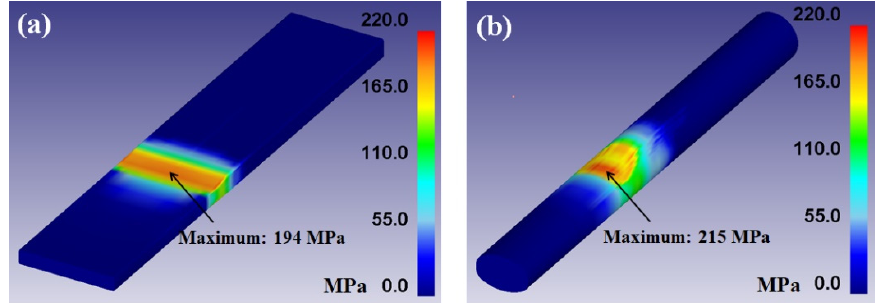
Figure 9. Contour maps of effective stress of ( a ) plate and ( b ) rod during the hot rolling process.